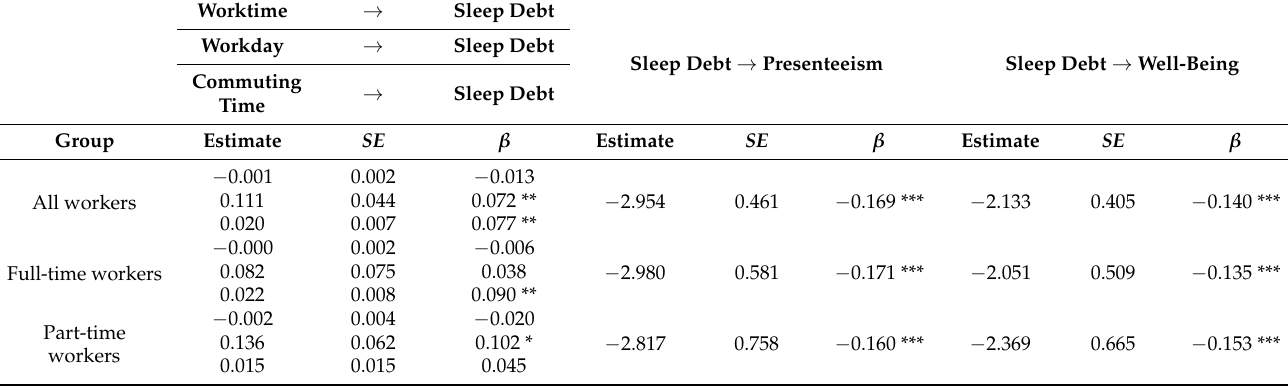
Table 4. Results of structural equation modeling for all, full-time, and part-time